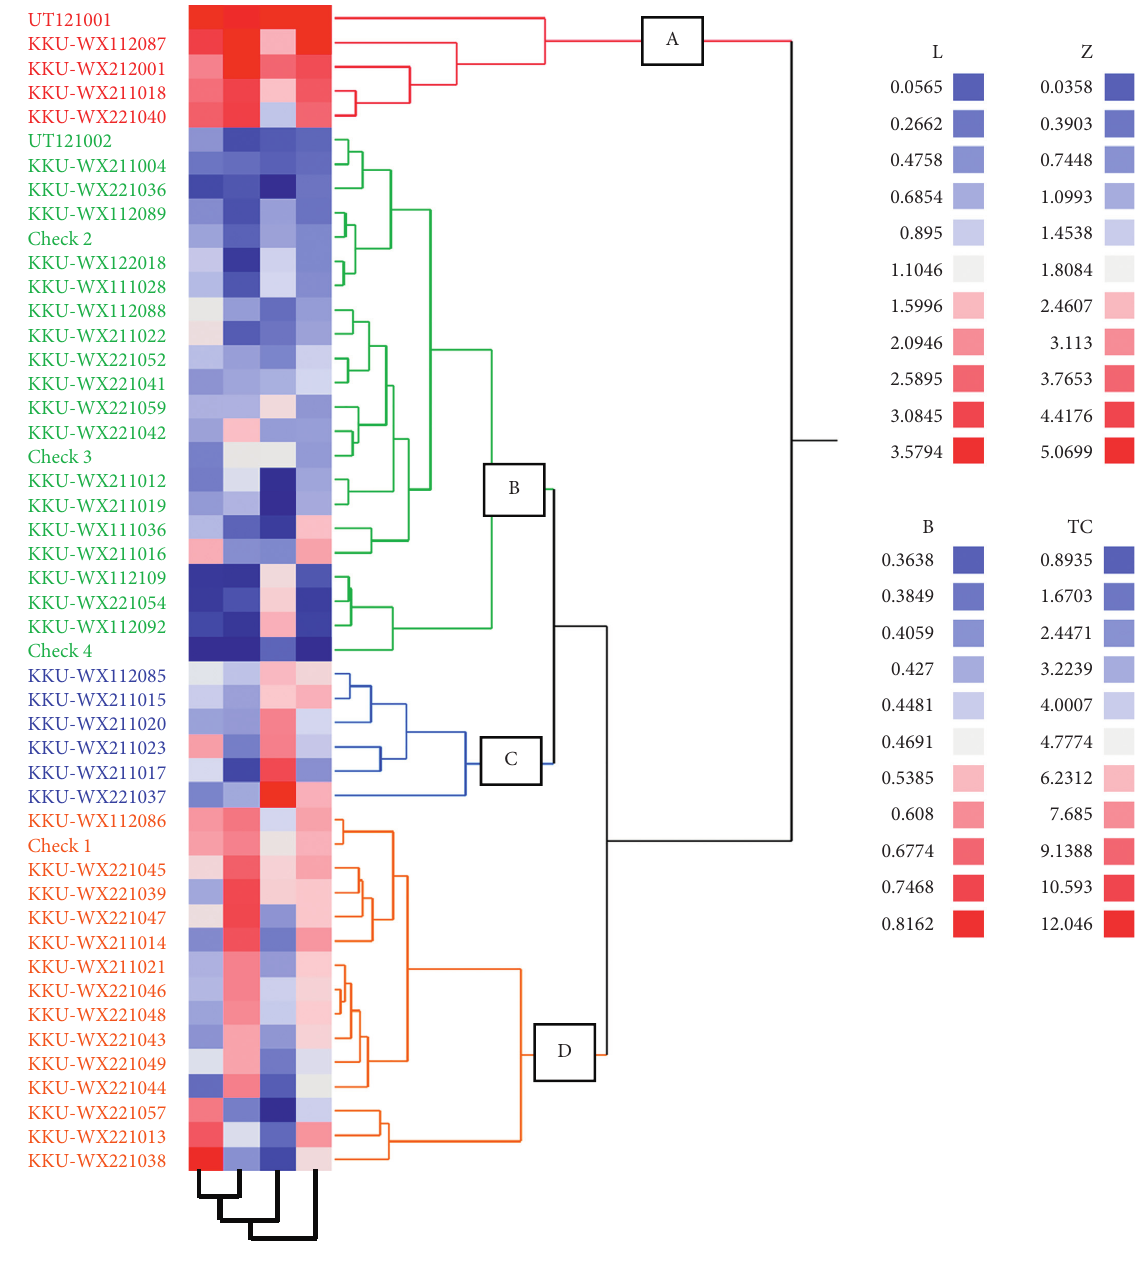
Figure 2: Dendogram of phenotypic relationships among 48 small-ear waxy corn genotypes. Four main clusters (A–D) were formed. Two- way Ward’s cluster analysis based on lutein (L), zeaxanthin (Z), beta-carotene (BC), and total carotenoids